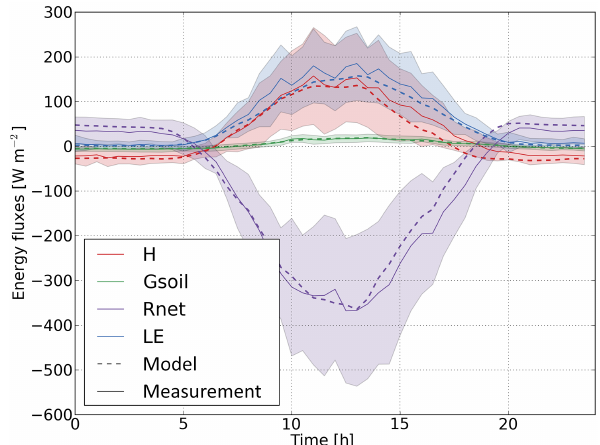
Figure 5. The monthly averaged diurnal cycle of different energy flux terms at 23m above the ground for model (dashed lines) and measurement (solid lines), including sensible heat flux ( H , red line), soil heat flux ( G soil , green line), upward net radiation ( R net , purple line, note the observed R net is at 67m) and latent heat flux (LE, blue line). The range of ± 1SD for measurement data is plotted for every term by the shade with the same